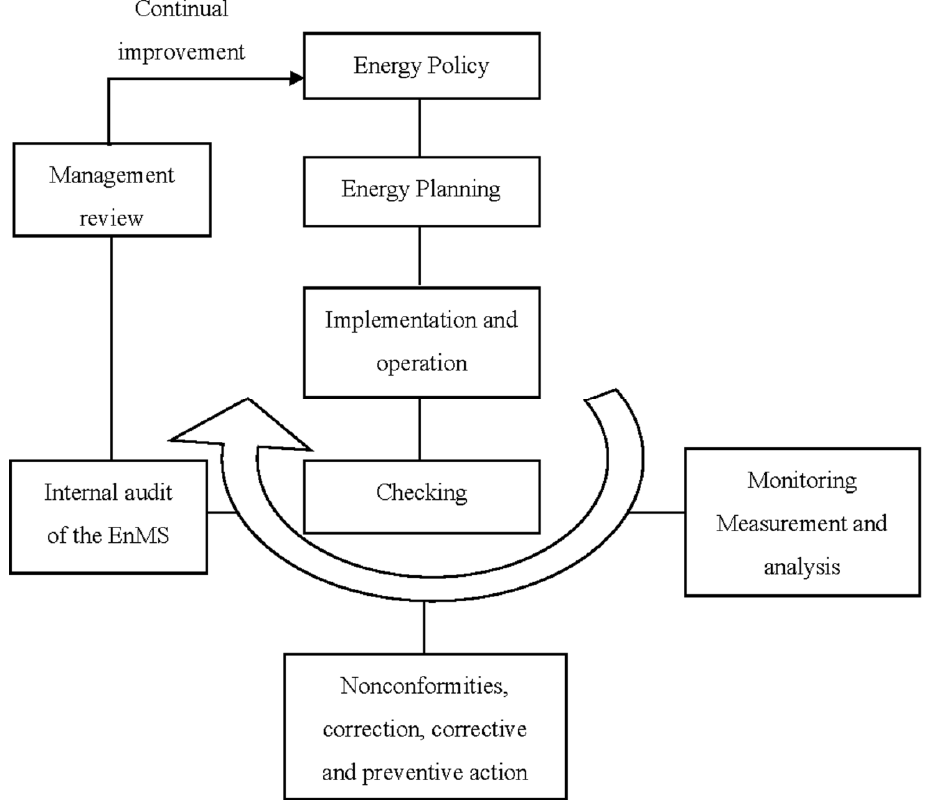
Figure 1. Energy management system model of ISO 50001 based on the ISO standard